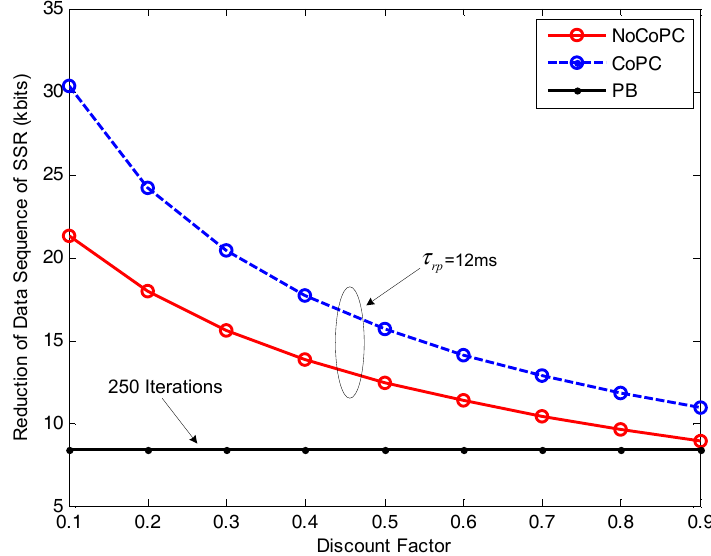
τ = ms, l = 250 iterations). rp